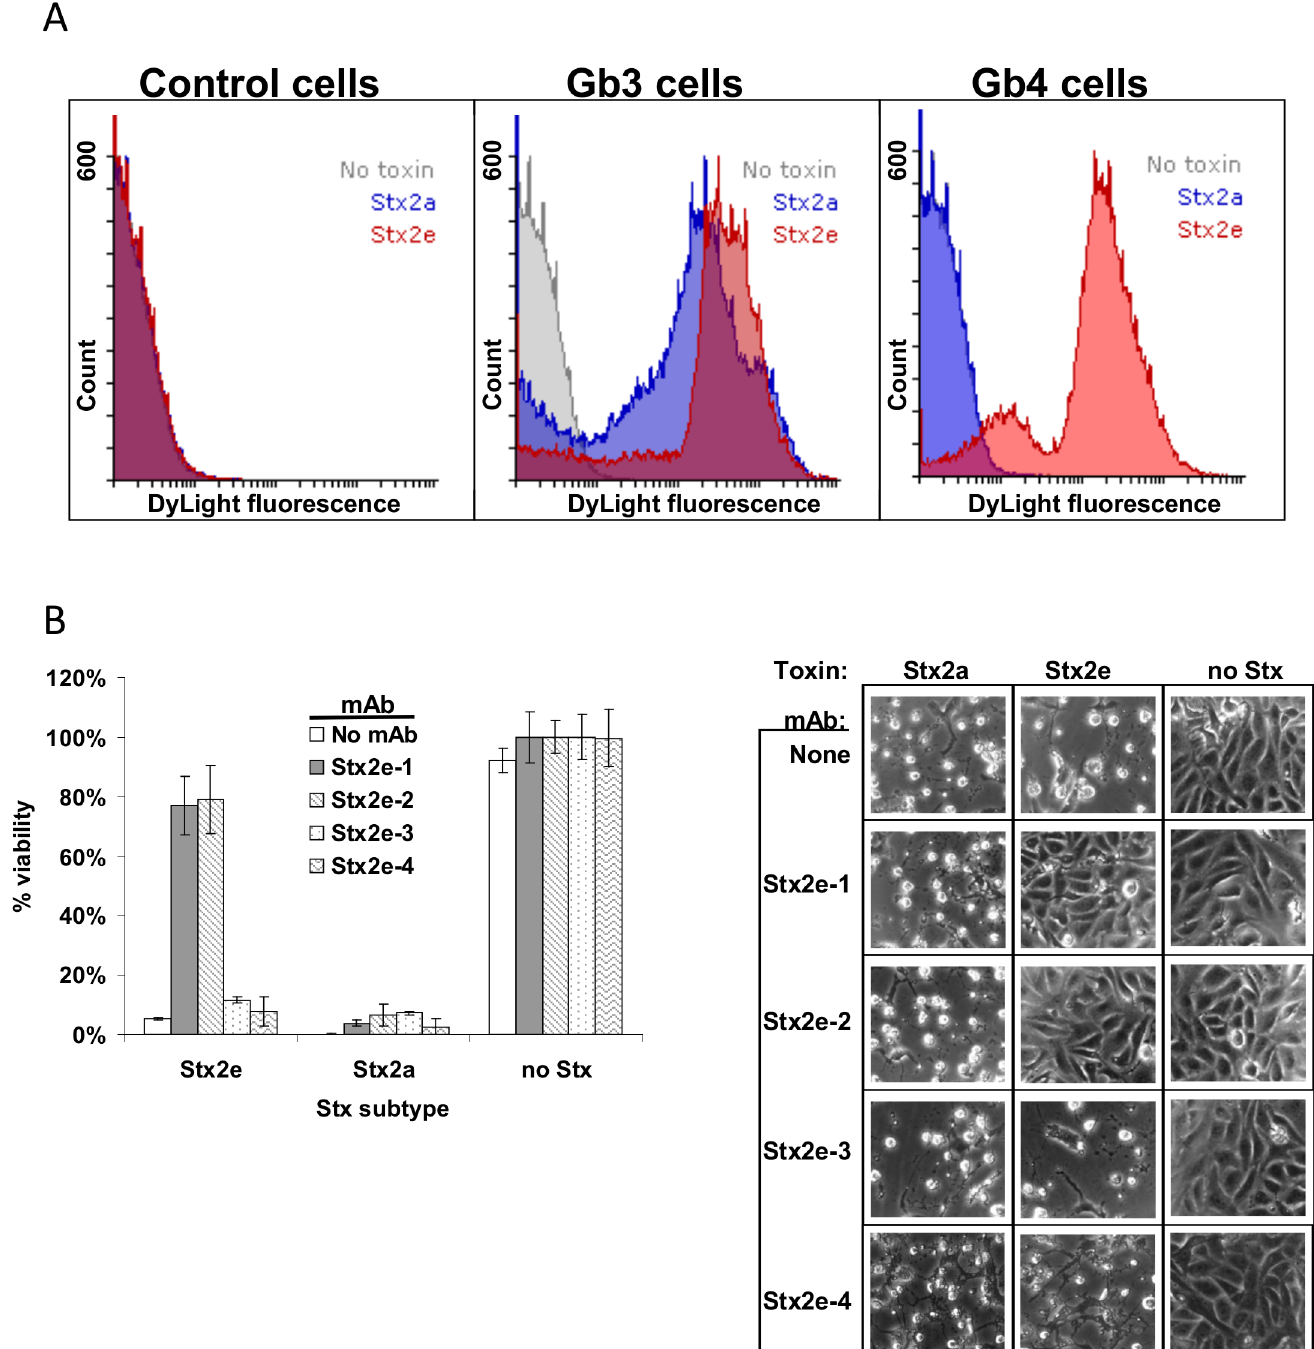
Fig 4. Receptor binding and neutralization of Stx2e. A) FACS analysis of Gb3-LPS, Gb4-LPS, and control E . coli cells. Stx2e (E167Q) and mAb Stx2e-3 were used at 1 μ g/mL, and 50,000 cells were analyzed per sample. B) Administration of mAbs Stx2e-1 or Stx2e-2 at 10 μ g/mL protects Vero cells from Stx2e toxicity (Stx2e-containing media at a 10-fold dilution). mAbs Stx2e-3 and Stx2e-4 (also at 10 μ g/mL) do not. None of the four mAbs protect Vero cells from Stx2a (Stx2a-containing media at a 10-fold dilution).